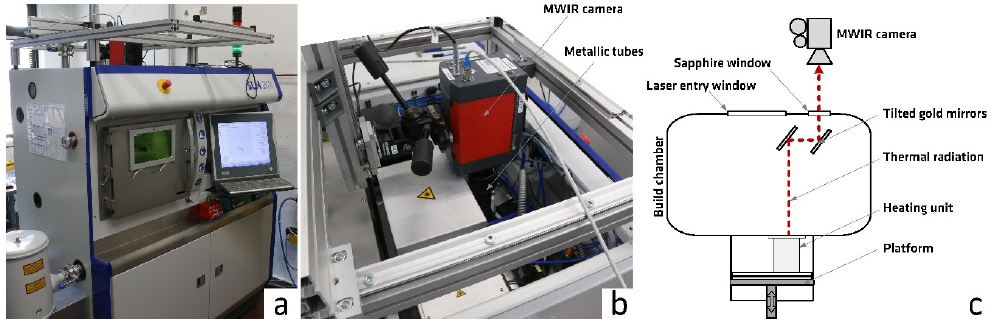
Figure 3. MWIR camera setup: installed camera on top of L-PBF machine (( a ) side view, dimensions of the process chamber: (280 × 280 × 360) mm 3 ; ( b ) top view, dimensions of the camera body; (244 × 120 × 160) mm 3 ; ( c ) schematic, not to scale).